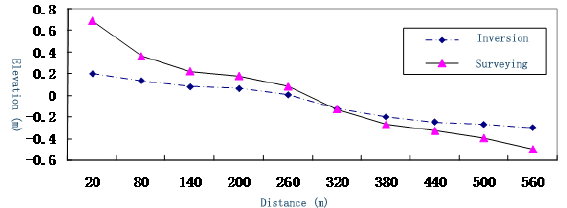
Figure.14 Inversion elevation transect compared with ground leveling with a horizontal interval of 60 m Compared the in-situ surveying data of the three transects and the inversion elevation data, the differences were partly high and partly low, the overall precision of the middle and high tide flat was better than the low tide flat. The variable trend was the descending from the land to the sea (Figure.14).